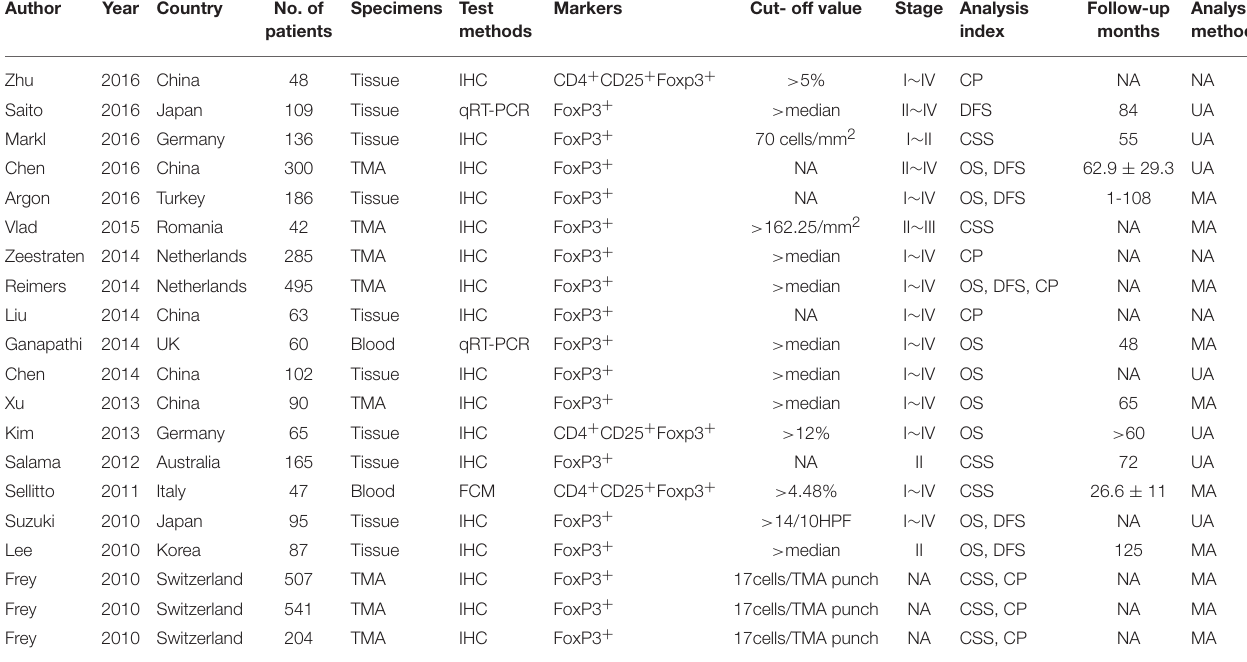
TABLE 1 | General characteristics of the studies included in this meta-analysis.